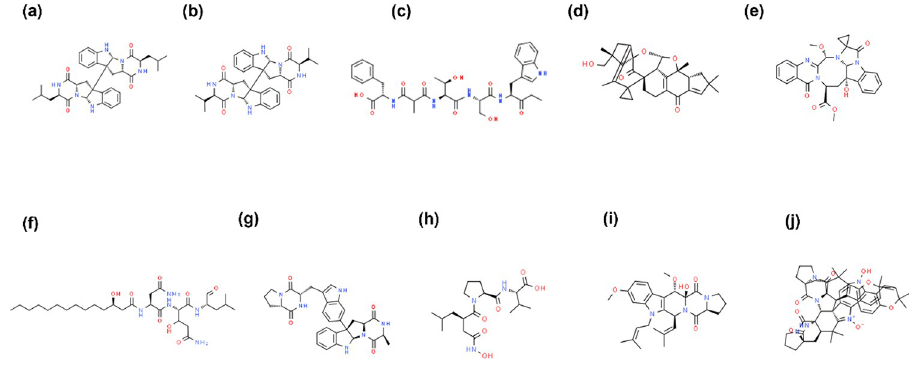
Fig 2. 2D representation of the top 10 compounds screened using NET1 model based on the predicted pIC 50 . (a) CMP1 (NET1) (b) CMP2 (NET1) (c) CMP3 (NET1) (d) CMP4 (NET1) (e) CMP5 (NET1) (f) CMP6 (NET1) (g) CMP7 (NET1) (h) CMP8 (NET1) (i) CMP10 (NET1) (j) CMP4 (NET1) .